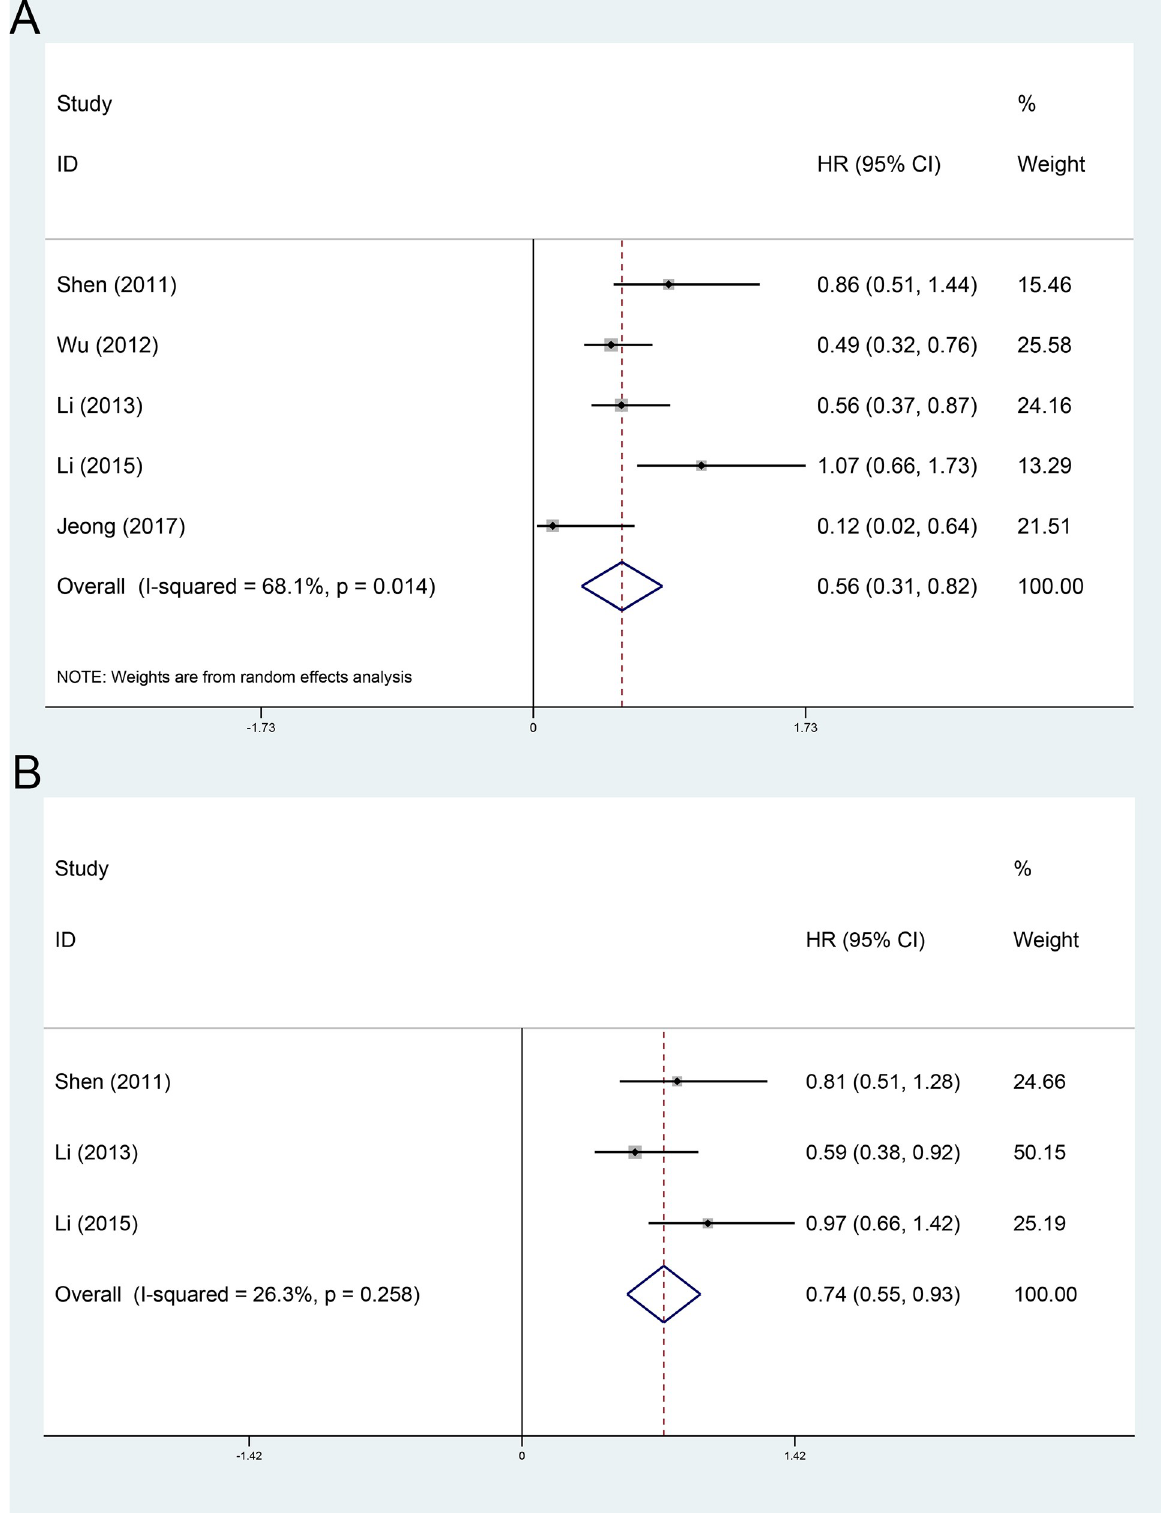
Fig 4. Forest plot of the overall survival and recurrence-free survival rates between adjuvant TACE and operation only. A, overall survival; B, recurrence-free survival.